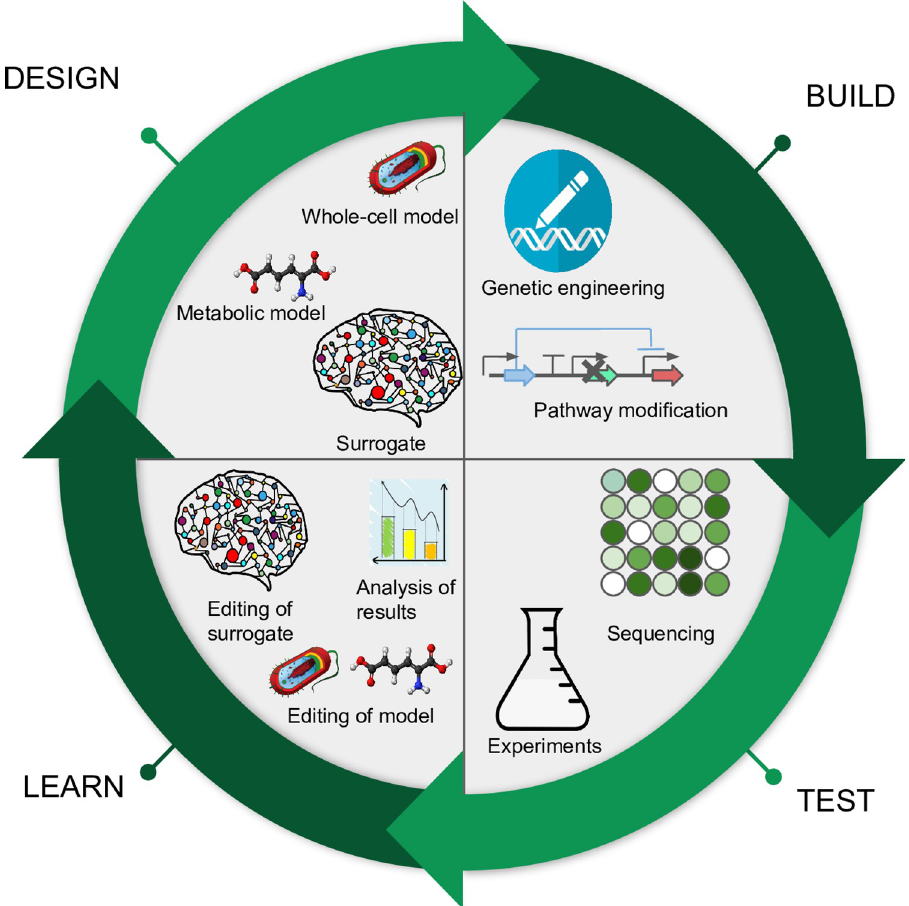
Fig 3. An example of the DBTL pipeline where the metabolic or whole-cell models can be replaced by surrogate models.